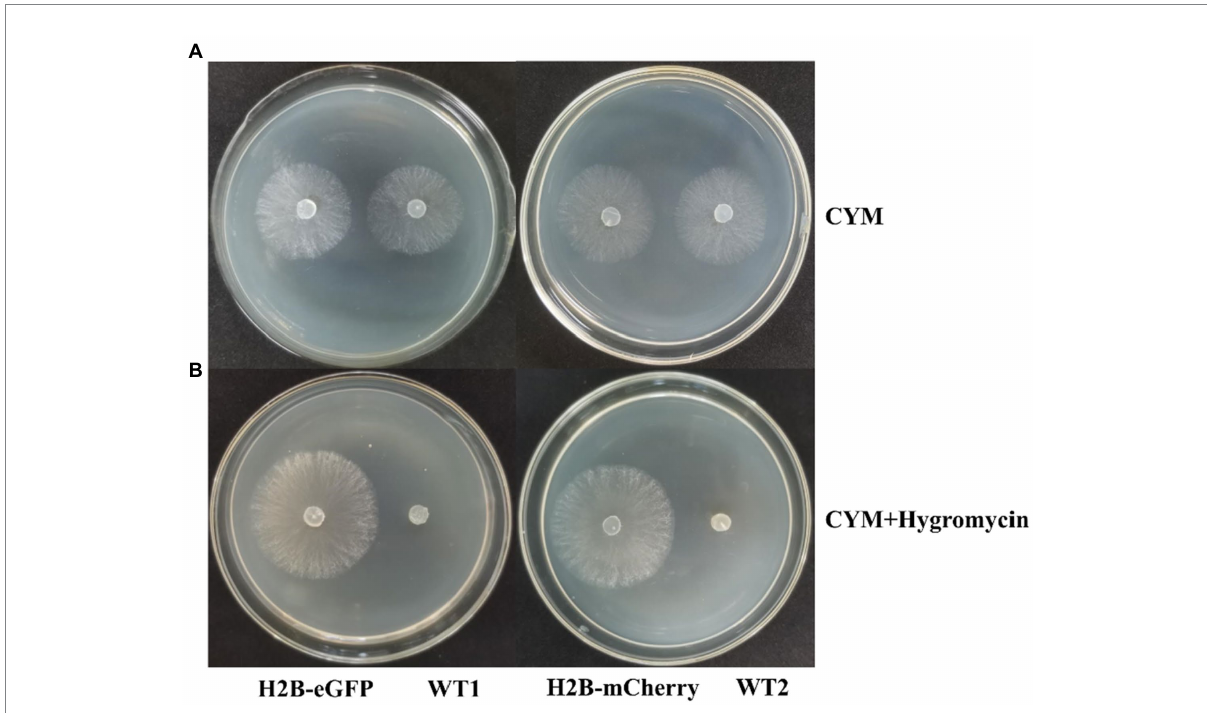
FIGURE 5 Expression of H2B-EGFP/mCherry does not influence hyphae growth. (A) Growth of H2B-EGFP/mCherry strains and wild type strains in CYM medium for 2 days at 23 ° C. (B) Growth of H2B-EGFP/mCherry strains and wild type strains in CYM medium supplemented with 10 μ g/ml hygromycin B for 3 days at 23 ° C. Two WT strains showed no growth under hph gene screening. H2B-EGFP, M04M24 transformant containing pEH2B plasmid; WT1, untransformed M04M24; H2B-mCherry, M04M26 transformant containing pMH2B plasmid; WT2, untransformed